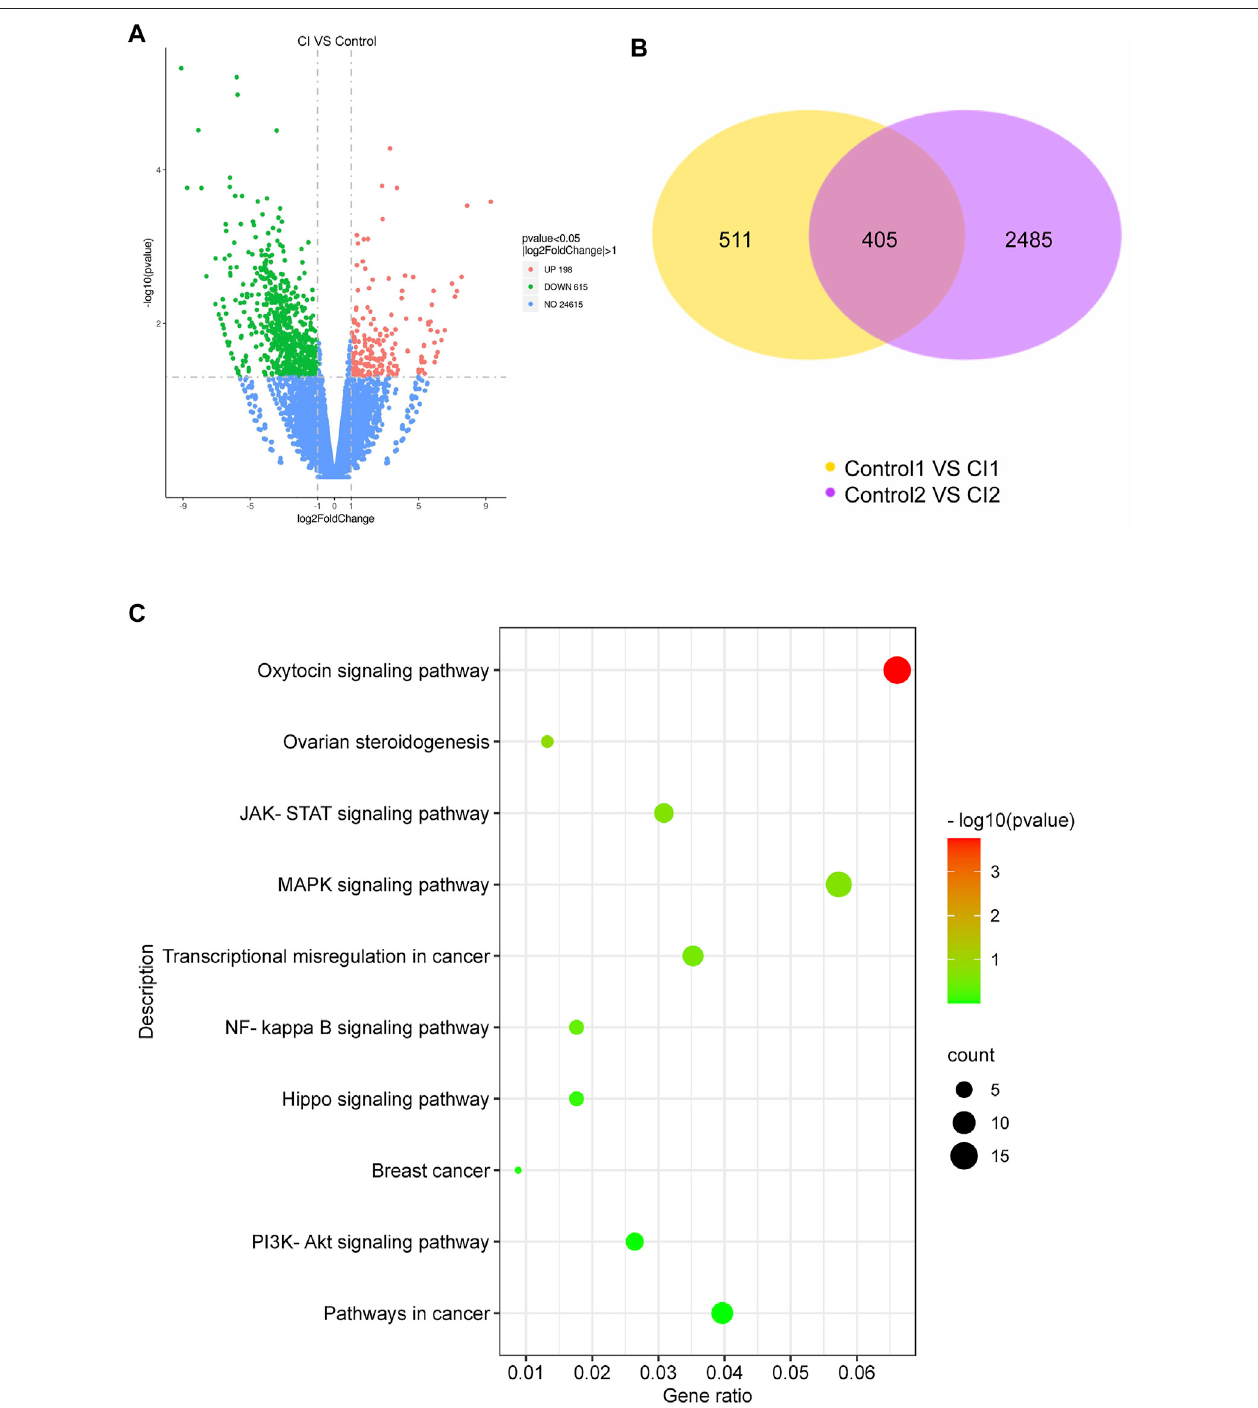
FIGURE 4 | Analysis of CI (0.5 g/kg)-regulated gene expression in 4T1 tumor. (A) Upregulated genes and downregulated genes in 4T1 tumor. (B) Differentially expressed genes between CI and control. (C) Top 10 cancer-related pathways found by enrichment analysis of the KEGG pathway for differential genes.